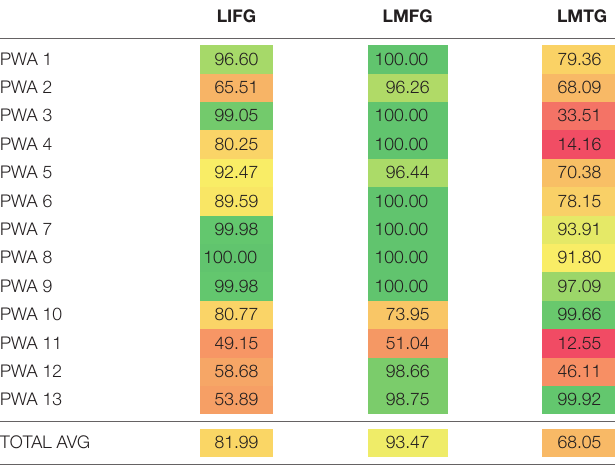
TABLE 3 | Percentage of spared tissue in LIFG, LMFG, and LMTG across